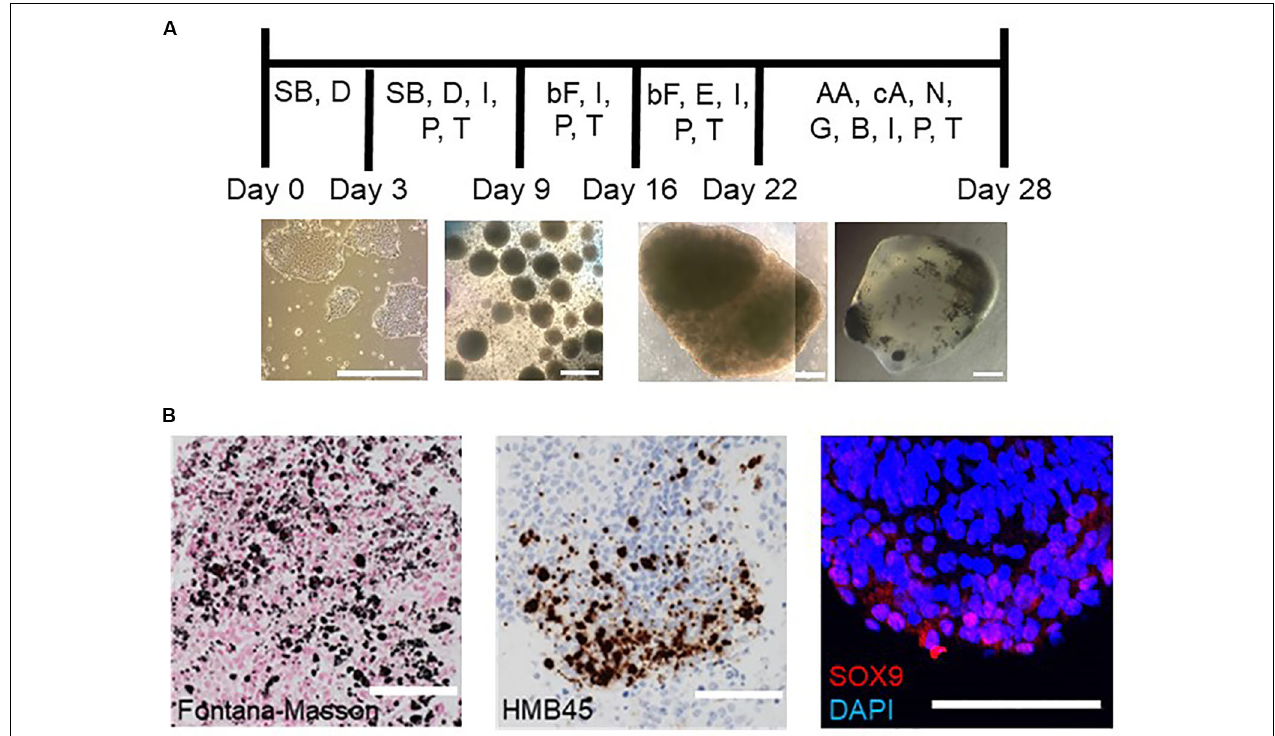
FIGURE 1 | Schematic procedure of inducing hBSOs and immunohistochemical analysis of 1-month-old hBSOs from hESCs. (A) Schematic procedure of generating human brainstem organoids. SB, SB431542; D, dorsomorphin; I, insulin; P, progesterone; T, transferrin; bF, basic fibroblast growth factor; E, epidermal growth factor; AA, ascorbic acid; cA, cyclic adenosine monophosphate; N, neurotrophin 3; G, glial cell line–derived neurotrophic factor; B, brain-derived neurotrophic factor. Photographs of organoids were taken on days 0, 9, 22, and 28. Bars = 500 µ m. (B) Immunohistochemistry of hBSOs at 1-month old from hESCs for the markers of melanocyte (Fontana–Masson, HMB45) and neural crest cell (SOX9). Bars = 100 µ